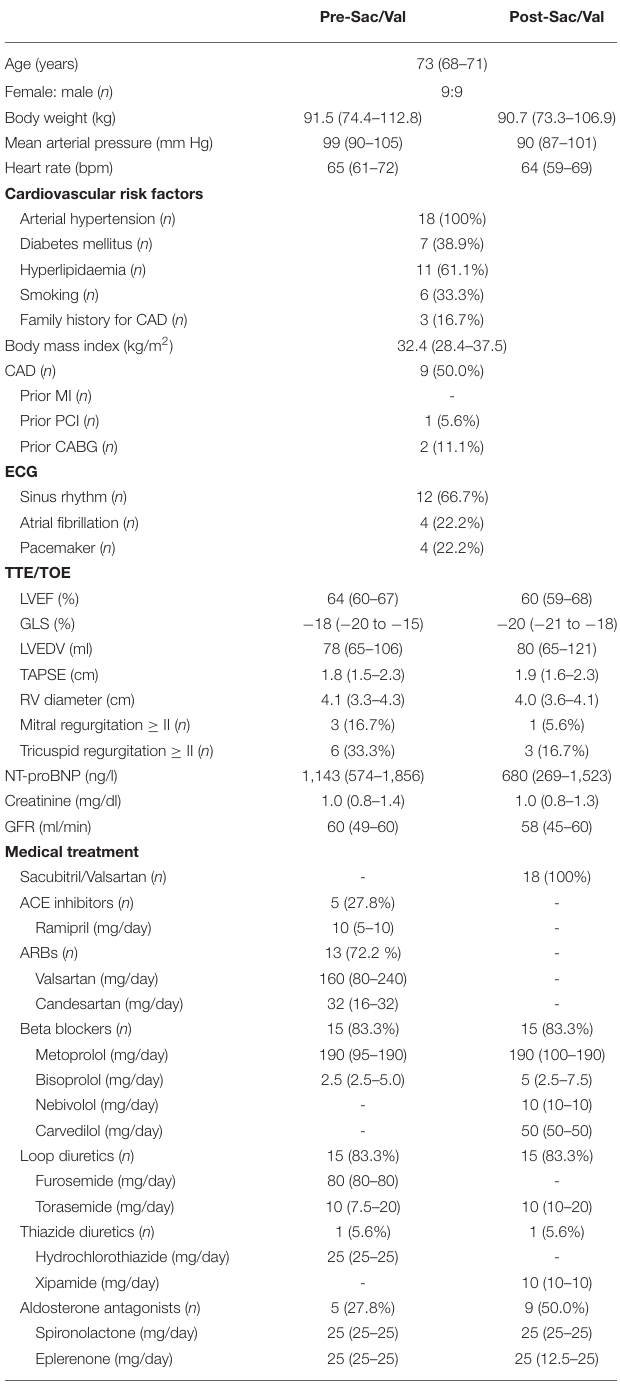
TABLE 1 | Patient characteristics ( n =